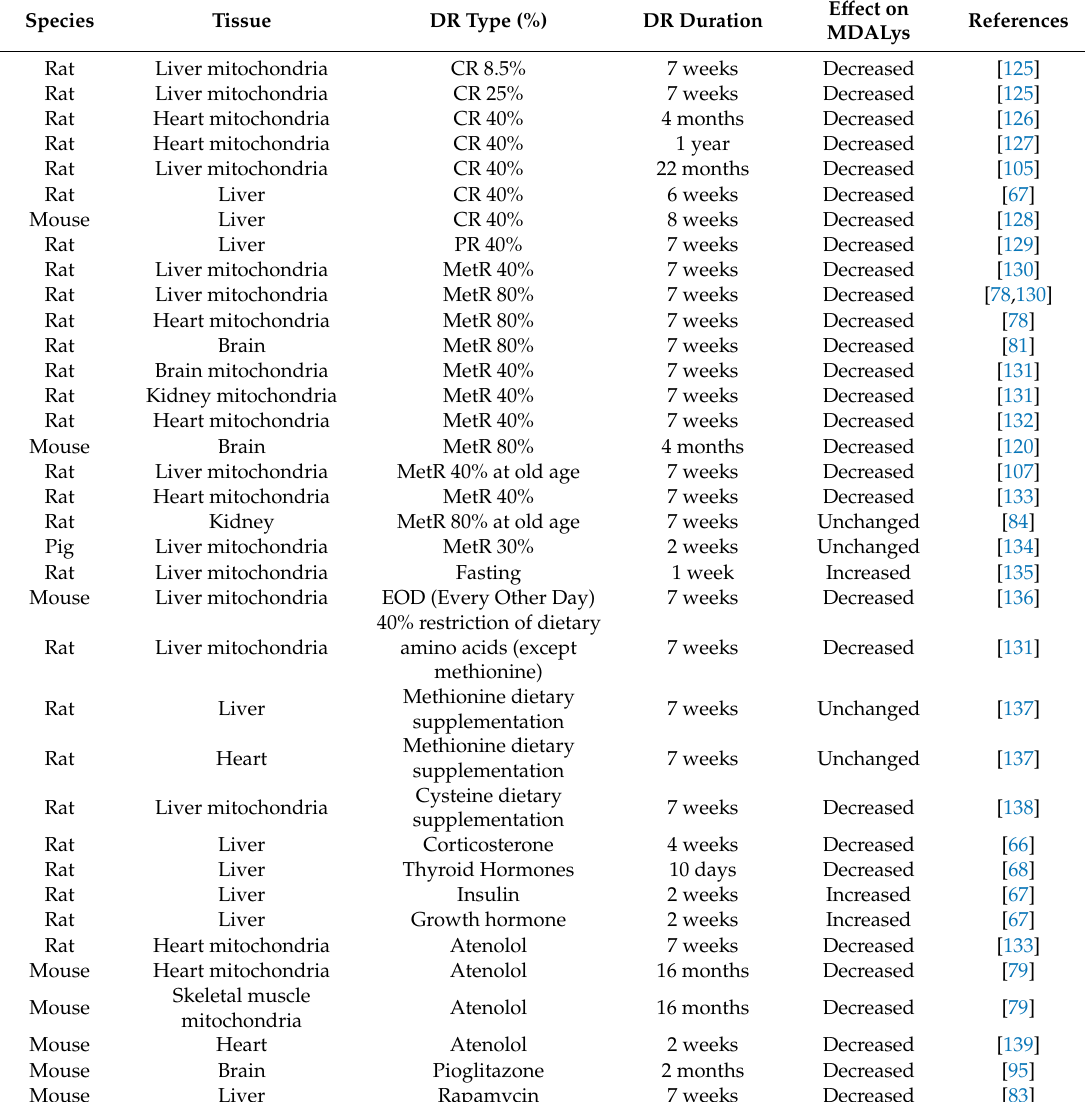
Table 5. E ff ect of pro-longevity and anti-aging nutritional and pharmacological interventions on MDALys concentration in di ff erent tissues and